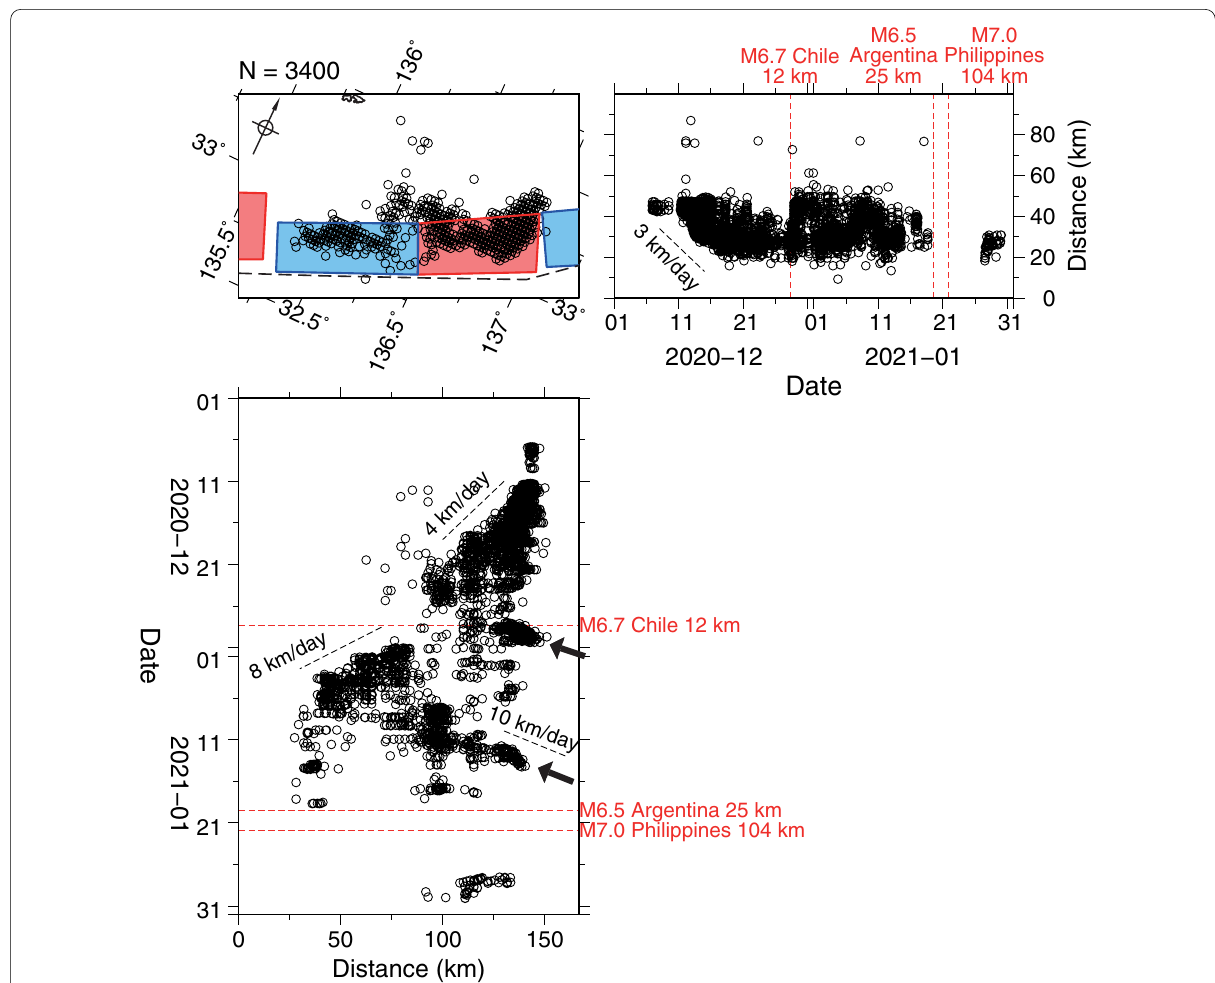
Fig. 4 Temporal variation of tremor locations along and normal to the trench axis. We selected tremors at depths shallower than 14 km and rotated map view N30 ◦ E that is parallel to the strike of the trench axis. The origin of the distances is (32.45 ◦ N, 135.7 ◦ E). Red and blue polygons in the map view indicate the areas of positive and negative reflection coefficients on the décollement, respectively. We visually determined the locations of these areas from Fig. 1 of Park et al. (2014). The thick black dashed line in the map view indicates the trench axis. Red dashed lines denote the origin time of teleseismic earthquakes, for which the approximate location, depth, and magnitude estimated by the GCMT project (Ekström et al. 2012) are reported. Black arrows indicate two RTR-like activities (see “Results and discussion”)